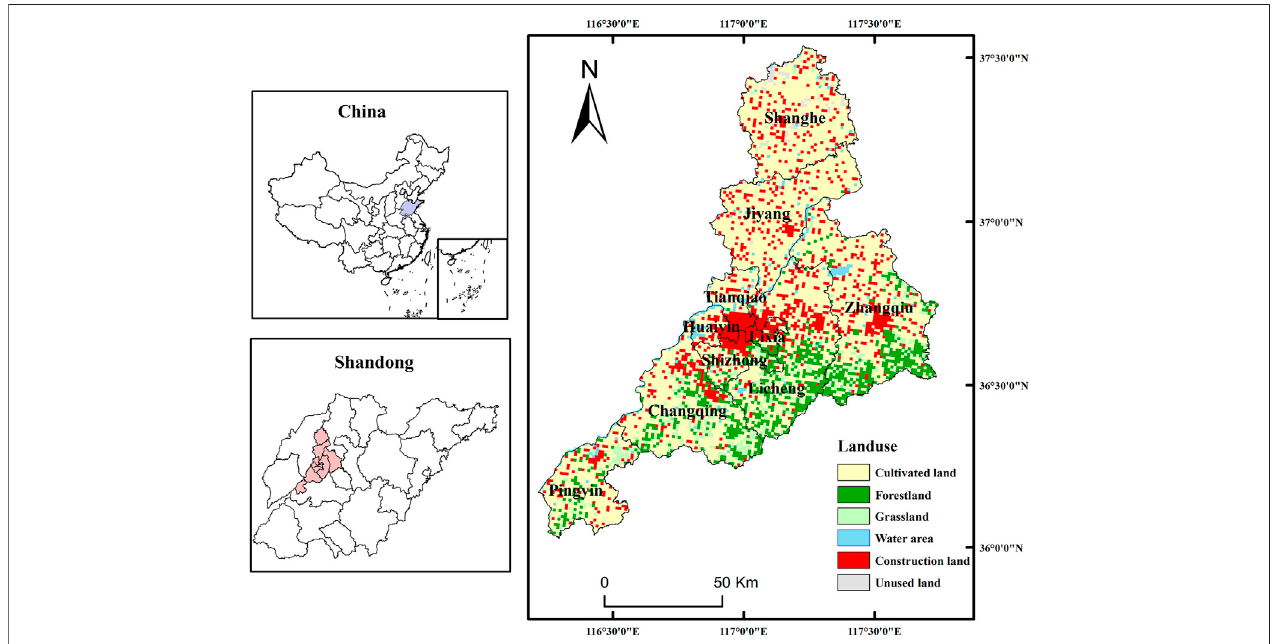
FIGURE 1 | Study area.